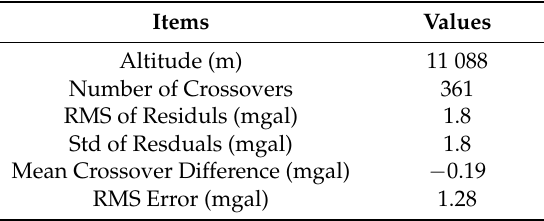
Table 2. Statistics of crossover error analysis in